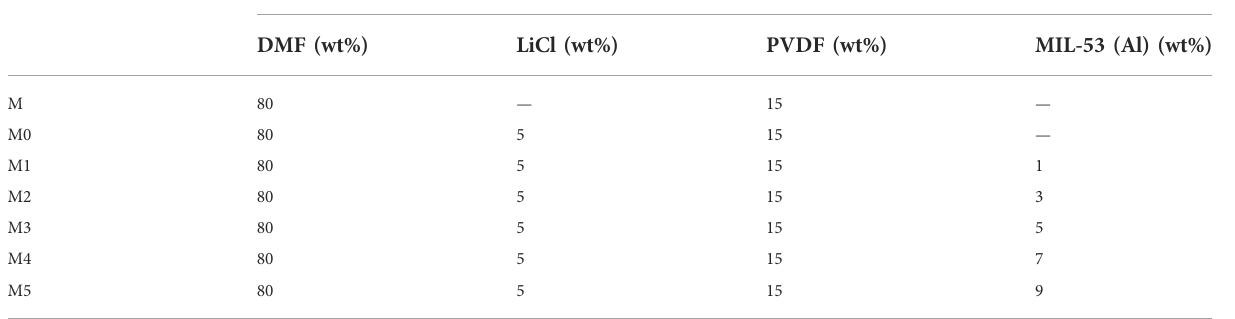
TABLE 1 The composition of the casting